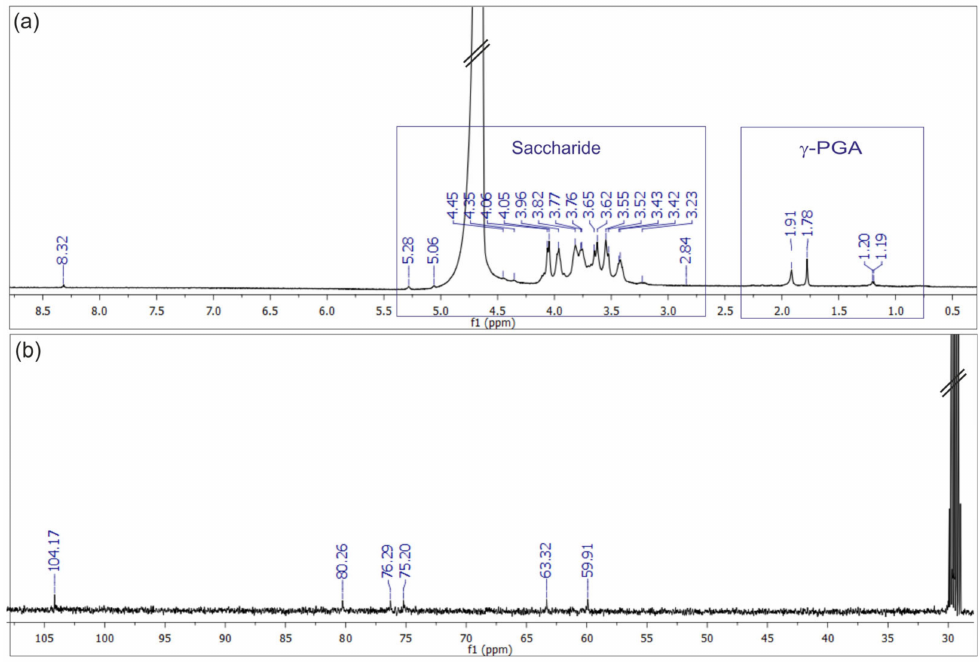
Figure 1. ( a ) 1 H-NMR and ( b ) 13 C-NMR spectra of crude EPS